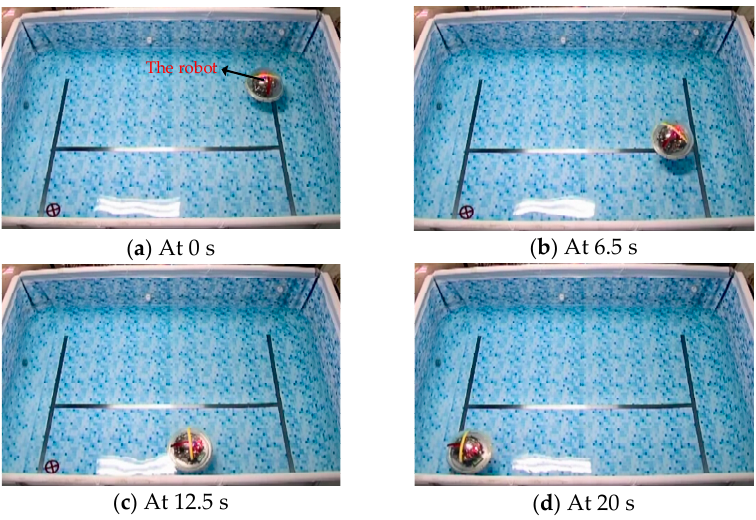
Figure 23. Experimental results for forward motion.